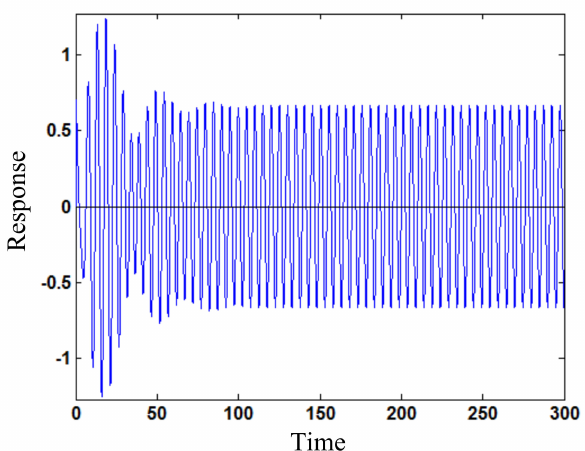
Figure 6. Smaller amplitude response ( w ) varying with time ( t ) for loading frequency ω = 1.24 by numerical simulation from initial displacement 1.0 and velocity 0.